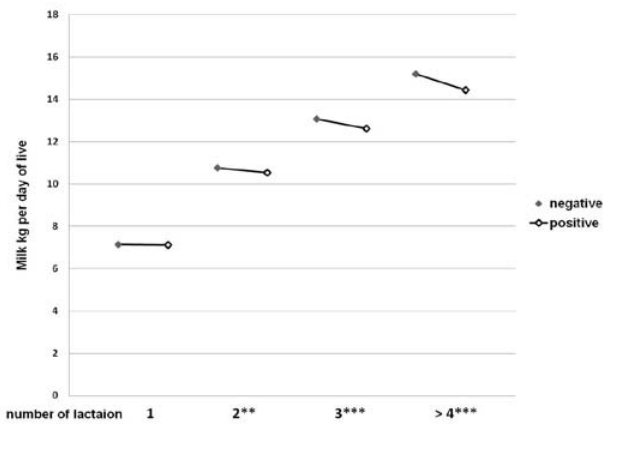
Figure 2 LS means for the milk per day of life in kg and number of lactation in faecal culture tested animals (* P≤ 0.05, ** P≤ 0.01, *** P≤